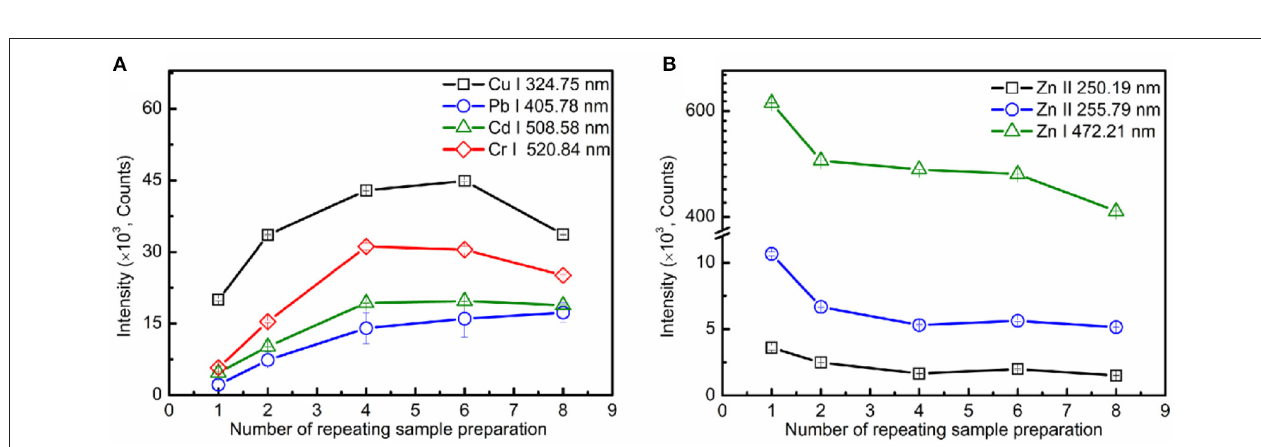
FIGURE 4 | Evolution trends of spectral intensity for analytical lines (A) and substrate element lines (B) on the number of repeating sample preparations.